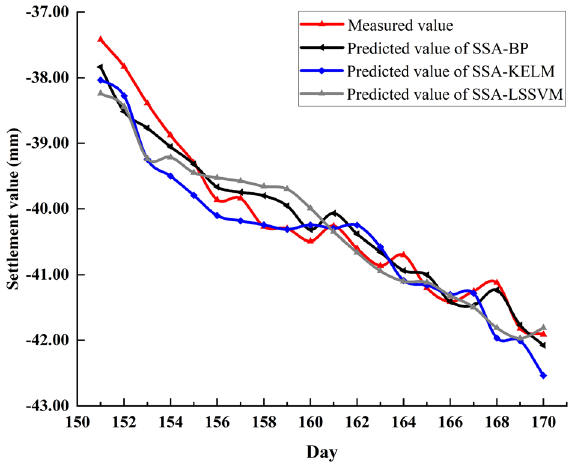
Figure 15. Comparison of predicted values of SAA-BP, SSA-KELM and SSA-LSSVM at point P2.